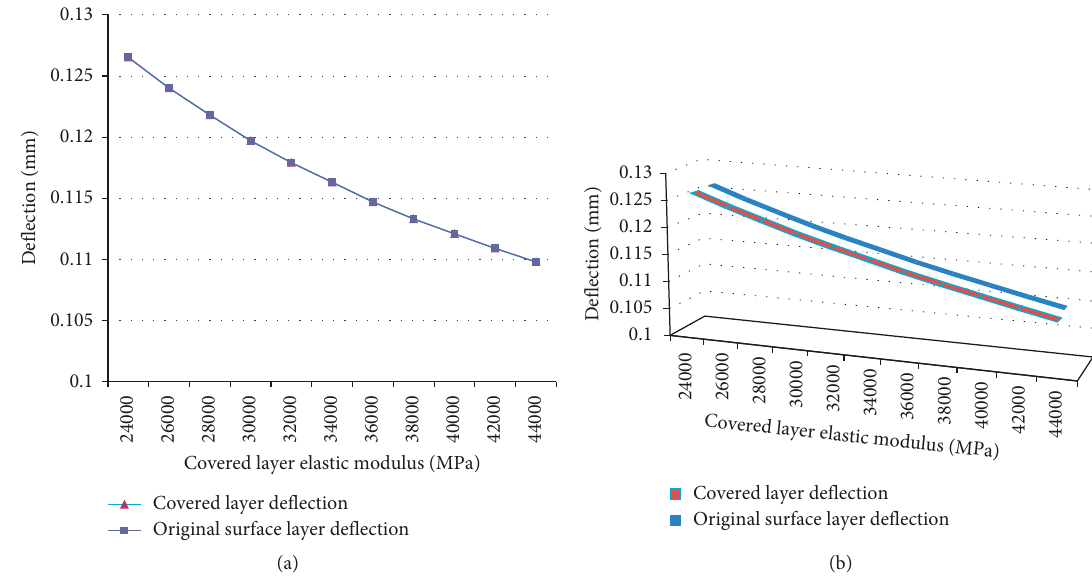
Figure 21: Variation of maximum deflection with covered layer elastic